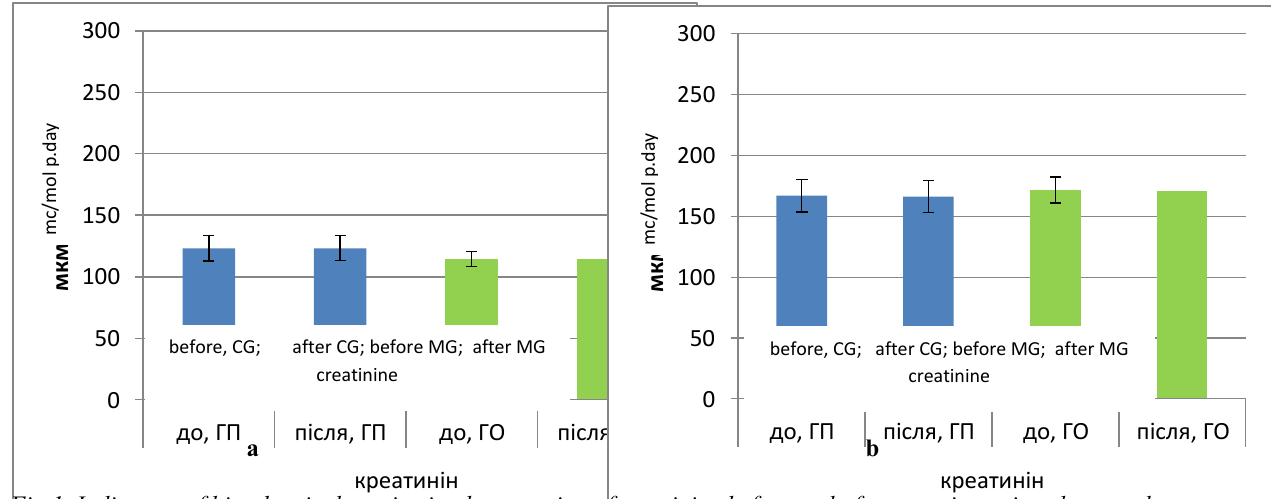
Fig.1. Indicators of bio-chemical monitoring by excretion of creatinine before and after experiment in a-lactate cluster (of main and comparative groups): a) by bicycle stress test «Vita maxima»; b) by results of control special tests. (р ≥ 0.05). CG – comparative group, MG – main group.